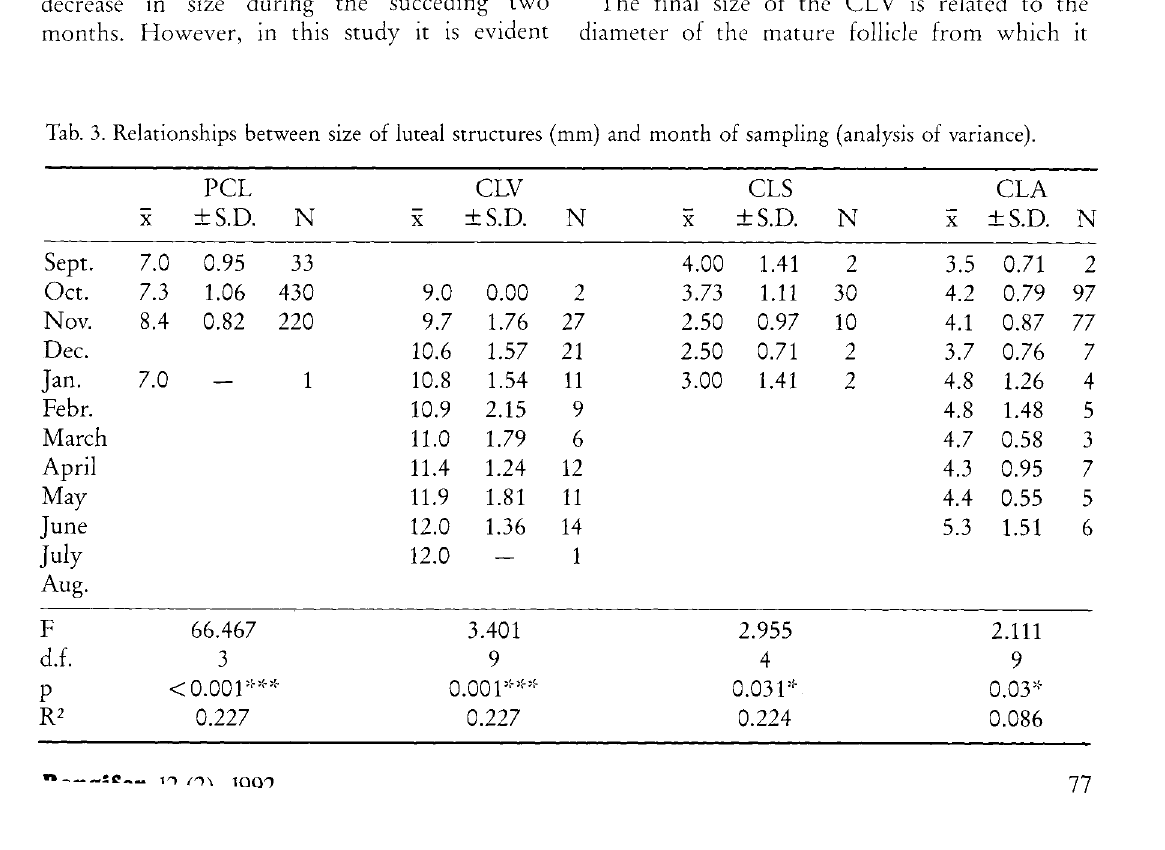
Tab. 3. Relationships between size of luteal structures (mm) and month of sampling (analysis of variance). P CL C